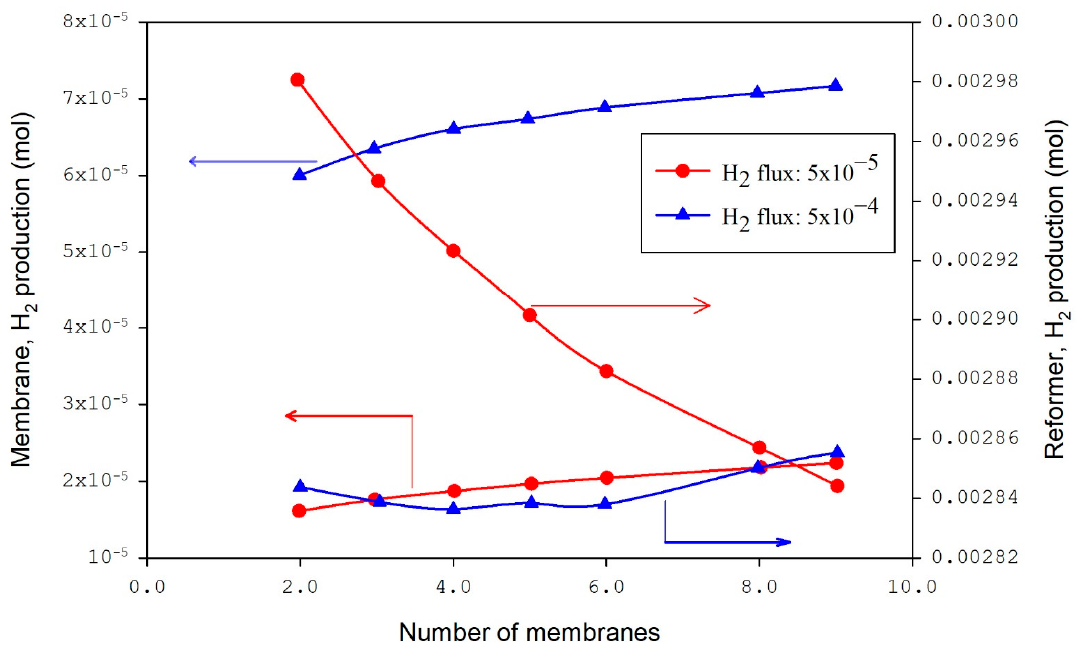
Figure 3. Hydrogen yield in membrane and reformer bed with variable fluxes of hydrogen [47].